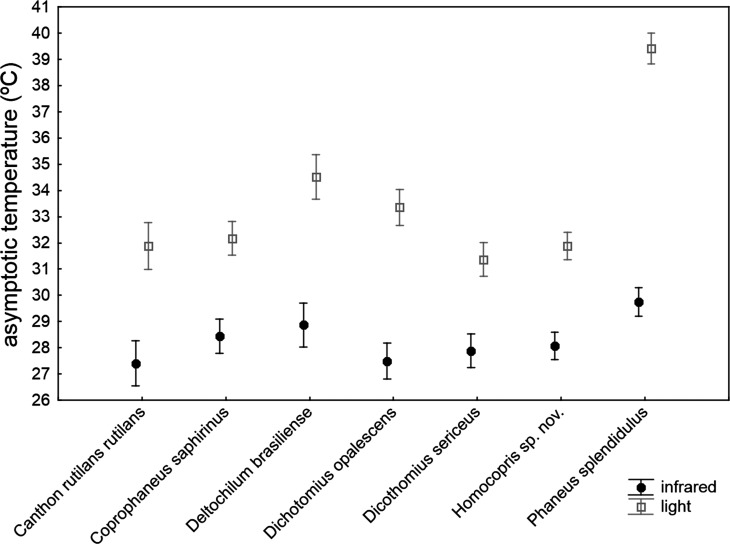
Mean ± one standard error of the maximum temperature internally reached by beetle exoskeletons in heating experiments (asymptotic temperature attained after ten minutes) in seven dung beetles (Scarabaeinae) under two sources of radiation: infrared radiation (infrared) and luminous radiation (light) resembling the electromagnetic spectrum of sun radiation.The values presented are adjusted means after controlling for the effect of the three covariates included in the ANCOVA model of Table 4 (control temperature, animal volume and weight per volume unit).